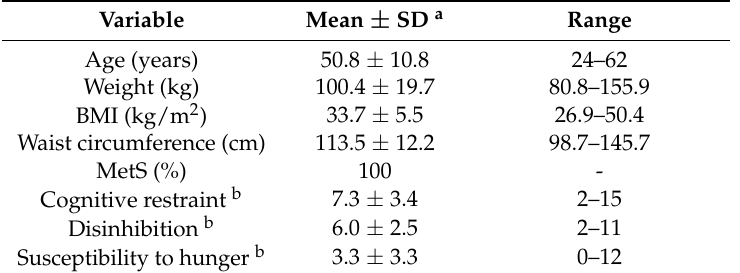
Table 2. Physical characteristics and eating behaviors scores of subjects at baseline ( n = 19).